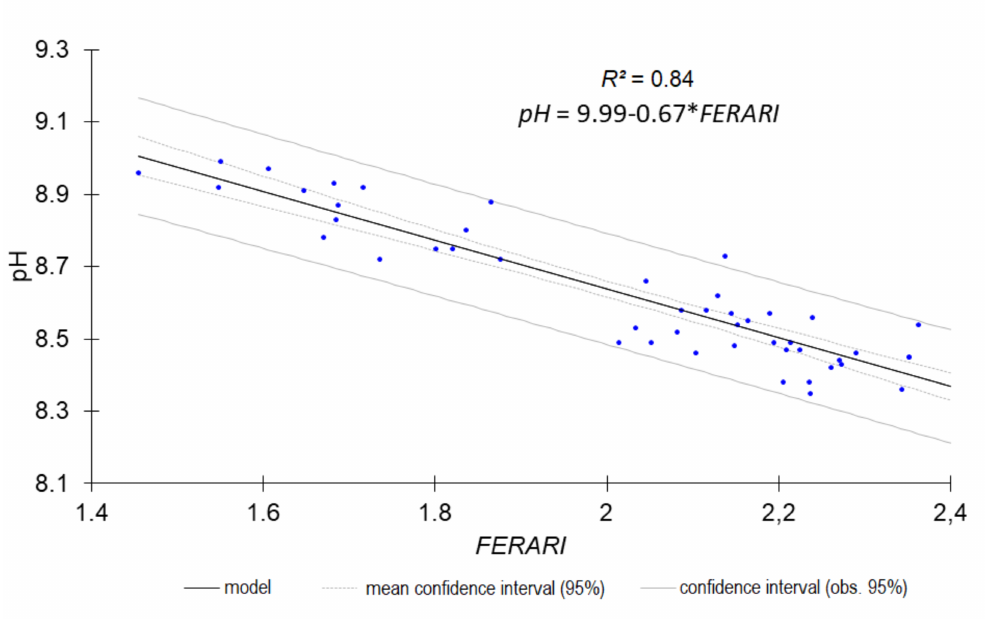
Figure 7. Predicted pH from single FERARI index (all horizons).